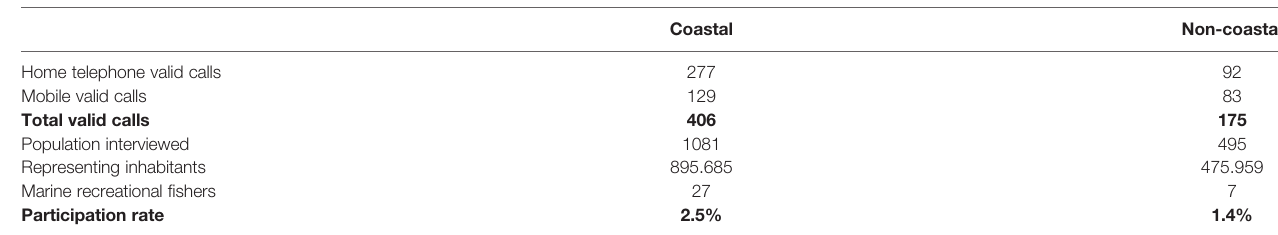
TABLE 1 | Telephone survey in Marche region.